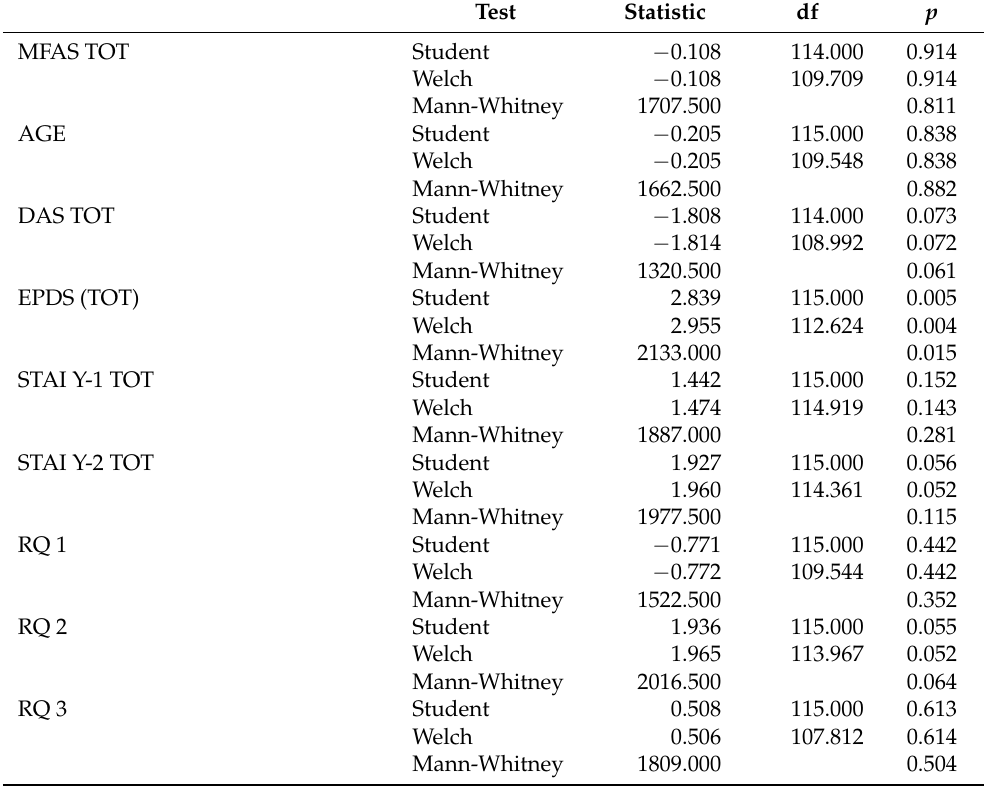
Table 5. Independent samples t -test—continuous variables versus breastfeeding one month after partum